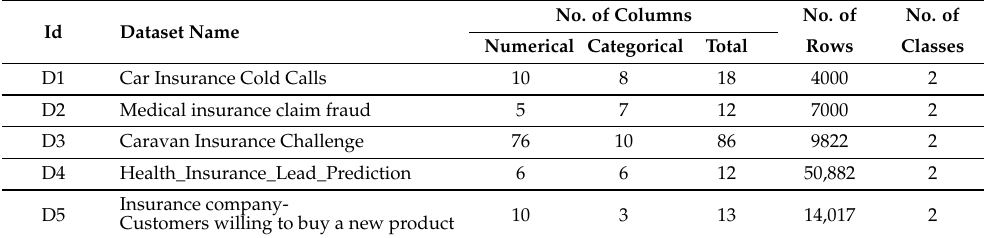
Table 1. Insurance datasets’